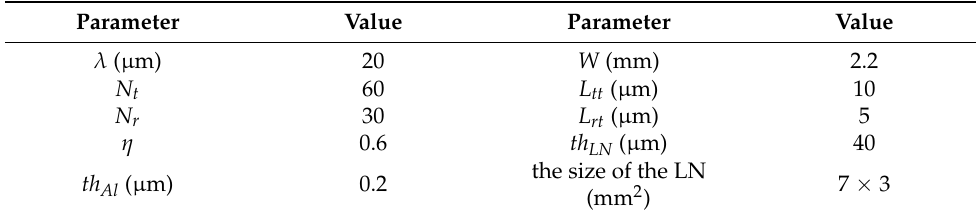
Table 6. Optimized structural parameters of a dual-port SAW resonator. Parameter Value Parameter Value